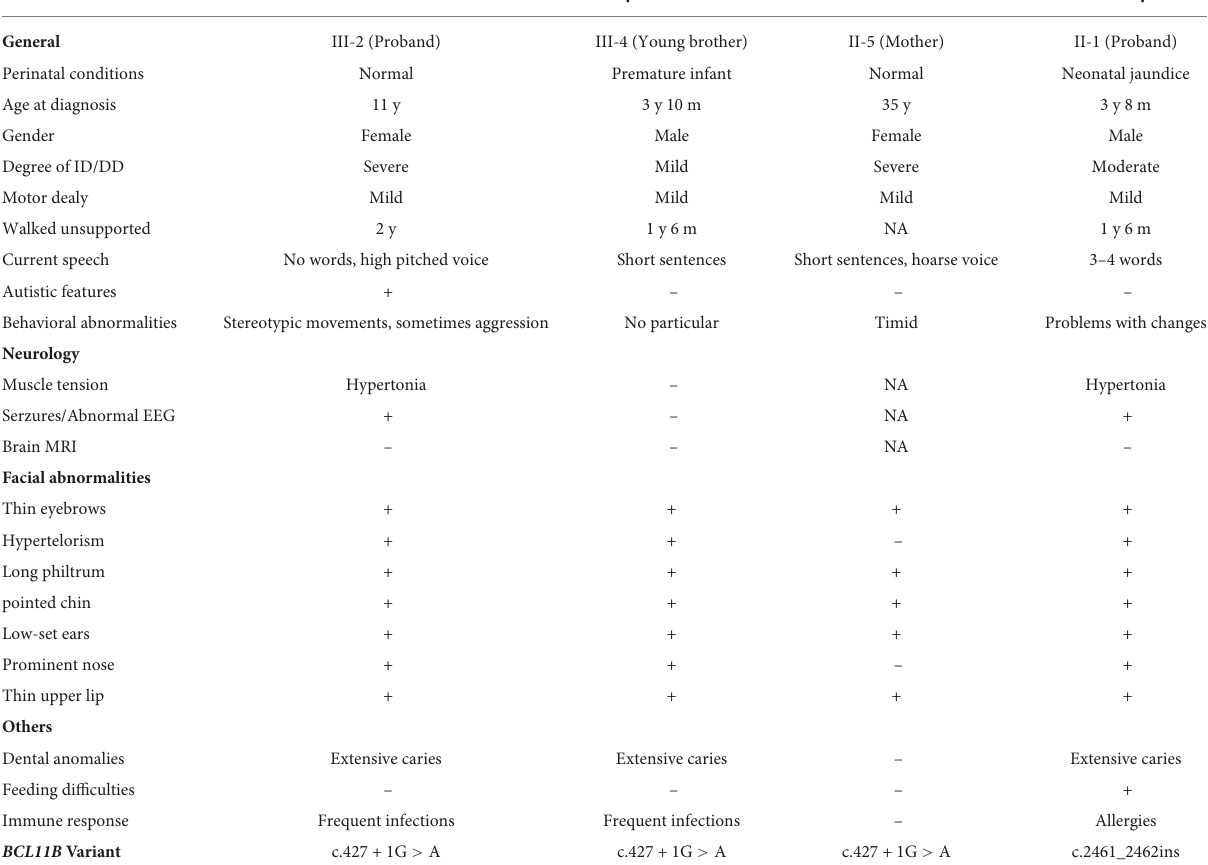
TABLE 1 Clinical features of the 4 patients with BCL11B variants.